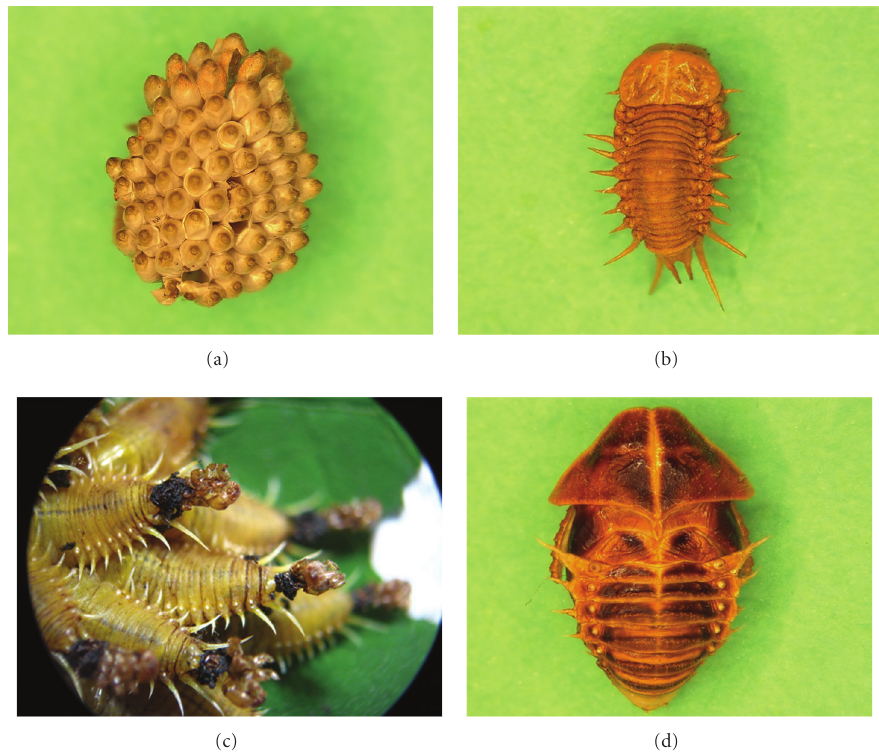
Figure 1: Immature stages of Omaspides pallidipennis Boheman, 1854 (Chrysomelidae). (a) Egg cluster, (b) dorsal view of last instar larvae, (c) exuvial-fecal shield, (d) pupae in dorsal view. Photos: (a), (b), and (d): Fl´avia